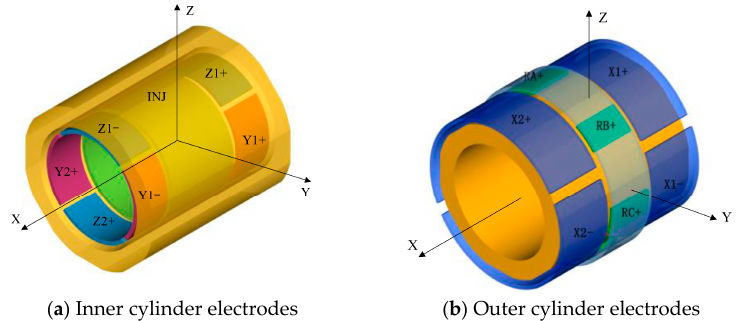
Figure 4. Electrode configuration of the NEP instrument with a cylindrical test mass (in orange): ( a ) On the inner cylinder are four quadrant electrodes on the vertical axis for z and θ , four electrodes on the horizontal axis for y and ϕ , and one injection electrode for capacitive position sensing; ( b ) On the outer cylinder are the x electrodes around the entire circumference, as well as a ring of six stator electrodes for rotation control around the x axis. Table 3. Parameters of the electrode cylinders.